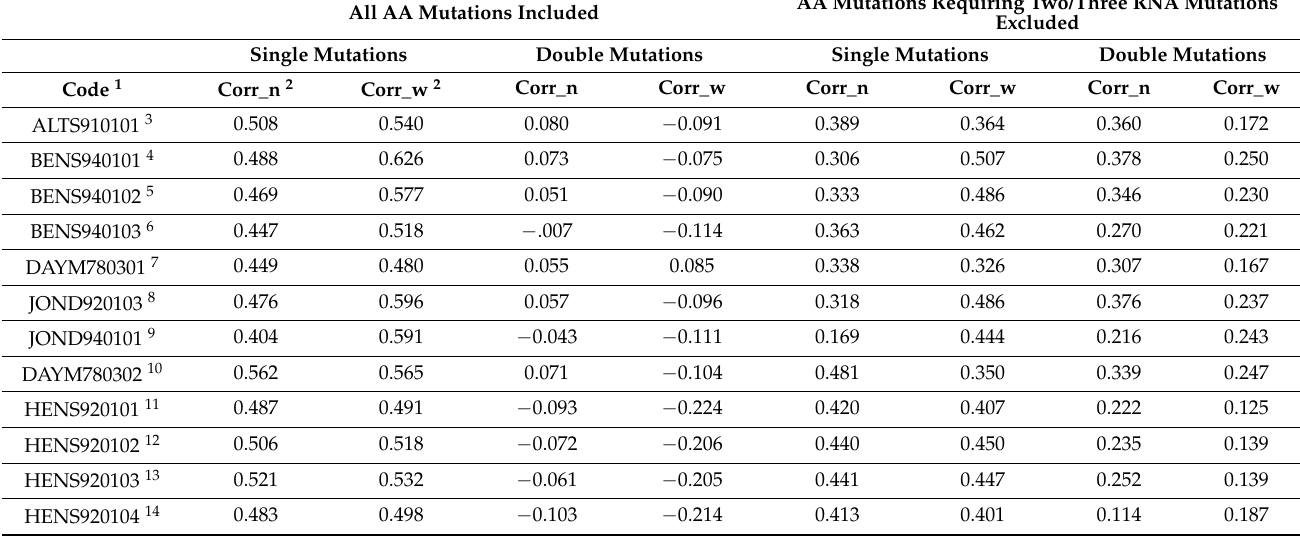
Table 4. Correlation between PAM or BLOSUM matrices and the number of mutation paths. All AA Mutations Included AA Mutations Requiring Two/Three RNA Mutations Excluded Single Mutations Double Mutations Single Mutations Double